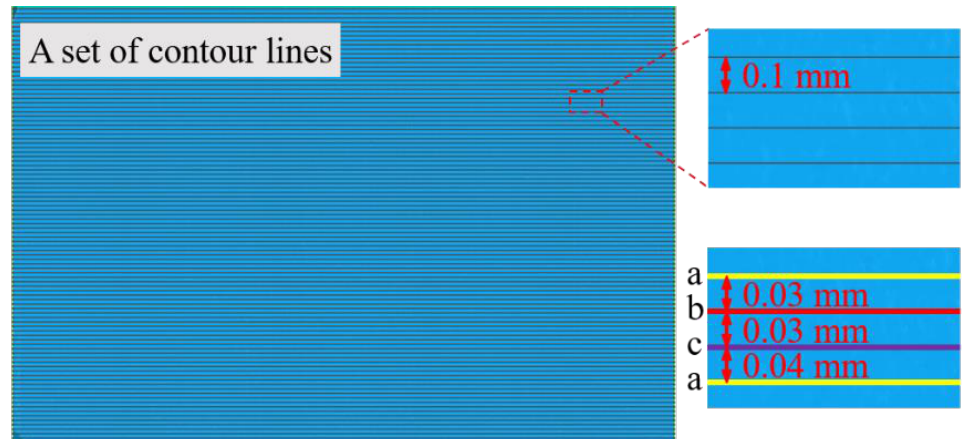
Figure 4. Selection of fault surface contour lines. The different letters (a, b, c) represent the contour lines in different contour line groups respectively.